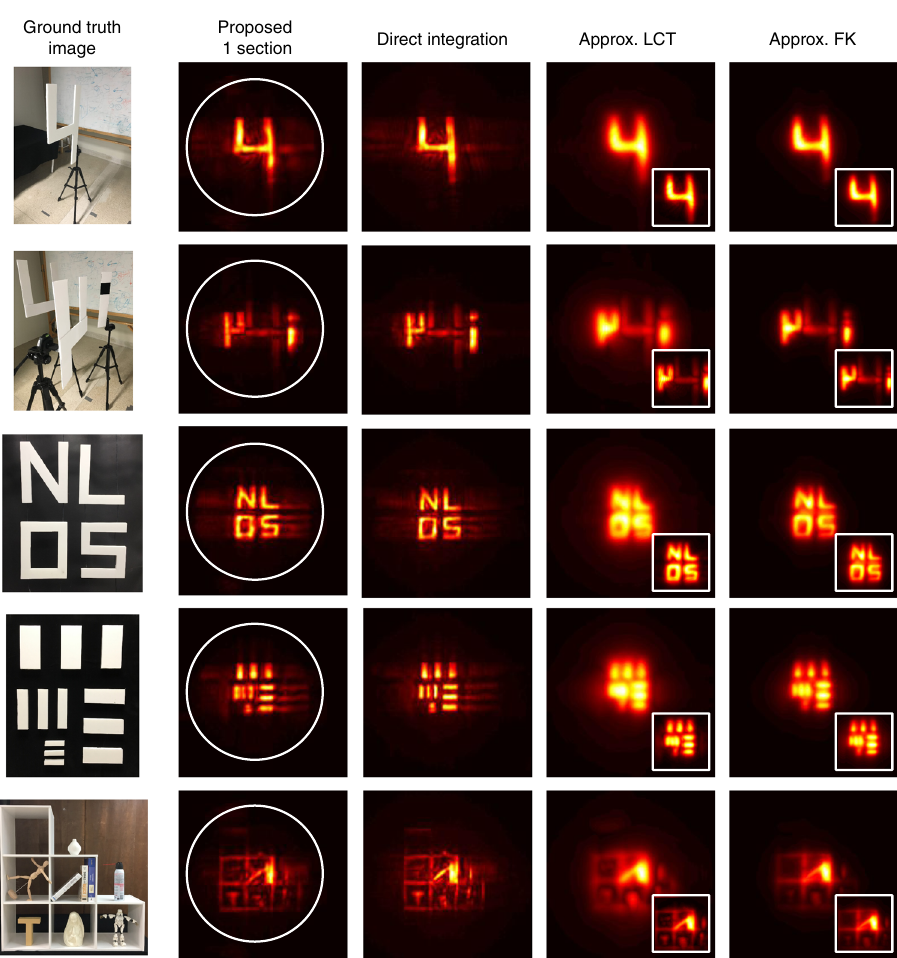
Fig. 8 Methods comparison on simple targets: Exposure time for these scenes are all 1000 ms per each pixel measurement. The total acquisition time for each target is 390 min. The width of the reconstruction cube size in each dimension is about 2 m as given along with other reconstruction parameters in Supplementary Table 4. Each row shows a different simple target, each column the reconstruction from different methods. The fi rst column stands for our proposed RSD based solver with one spatial section (inside white circle) corresponding to Eq. (13). The second column is from Direct Integration (back- projection solver) for comparison with the fi rst column. The last two columns show the approximate method 9 which approximate non-confocal as a confocal datasets and reconstruct through confocal solvers (LCT: forth column, FK-migration: fi fth column). For the last two columns, each small image shows the results from midpoint approximation 9 in order to approximate confocal data from non-confocal measurements. The respective larger image results from zero-padding applied to the input data to show the same reconstruction volume as the fi rst three